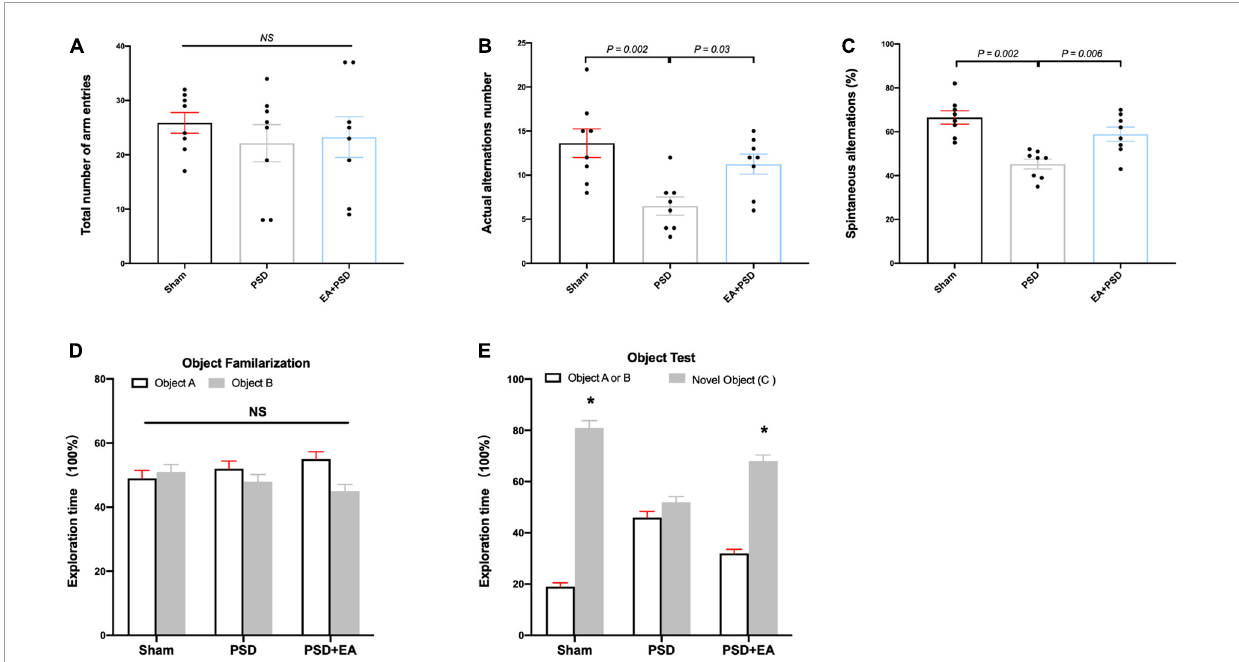
FIGURE2 EA treatment improved the cognitive dysfunction which was produced by PSD. (A–C) PSD exposure produced a significant impairment of spatial working memory and spatial cognitive ability, which was restored by EA treatment. (D) Time of mice spent exploring two identical object A or object B in the phase of familiarization. (E) Time of mice spent exploring familiar object A or B and novel object C during the recognition period ( n = 8, * P < 0.05 vs. familiar object A or B